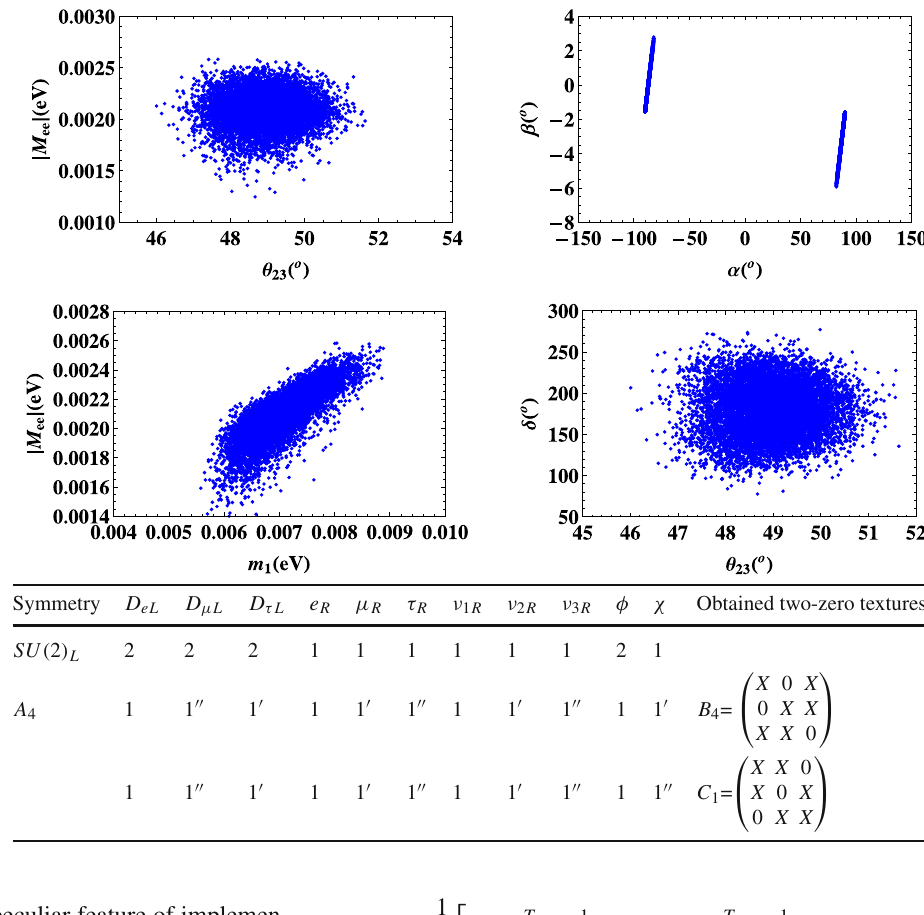
charge assignments in the model under SU ( 2 ) L and A 4 symmetries